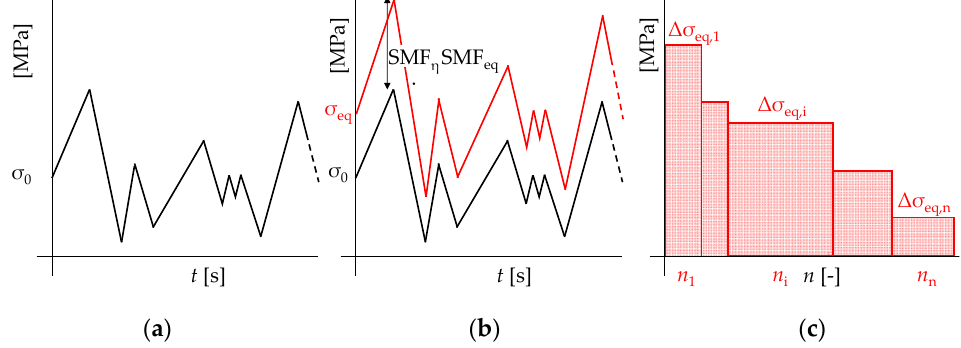
Figure 3. Estimation of “real” load spectrum from aperiodic stress histories according to the proposed methodological approach: ( a ) “unaltered” stress oscillograms, ( b ) “real” and “equivalent” stress oscillograms, and ( c ) “equivalent” load spectrums.